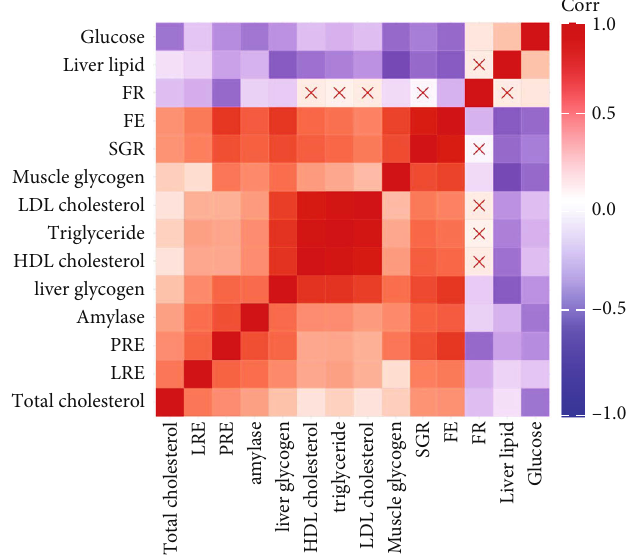
Figure 2: Correlation plot for the associations between 14 parameters re fl ecting the physiological responses of three gibel carp strains fed di ff erent dietary carbohydrate sources. The colours represent the degree of pairwise correlation regarding Spearman ’ s correlation coe ffi cient ( r ). Red indicates a signi fi cantly positive correlation, blue indicates a signi fi cantly negative correlation, and X indicates no signi fi cant correlation.